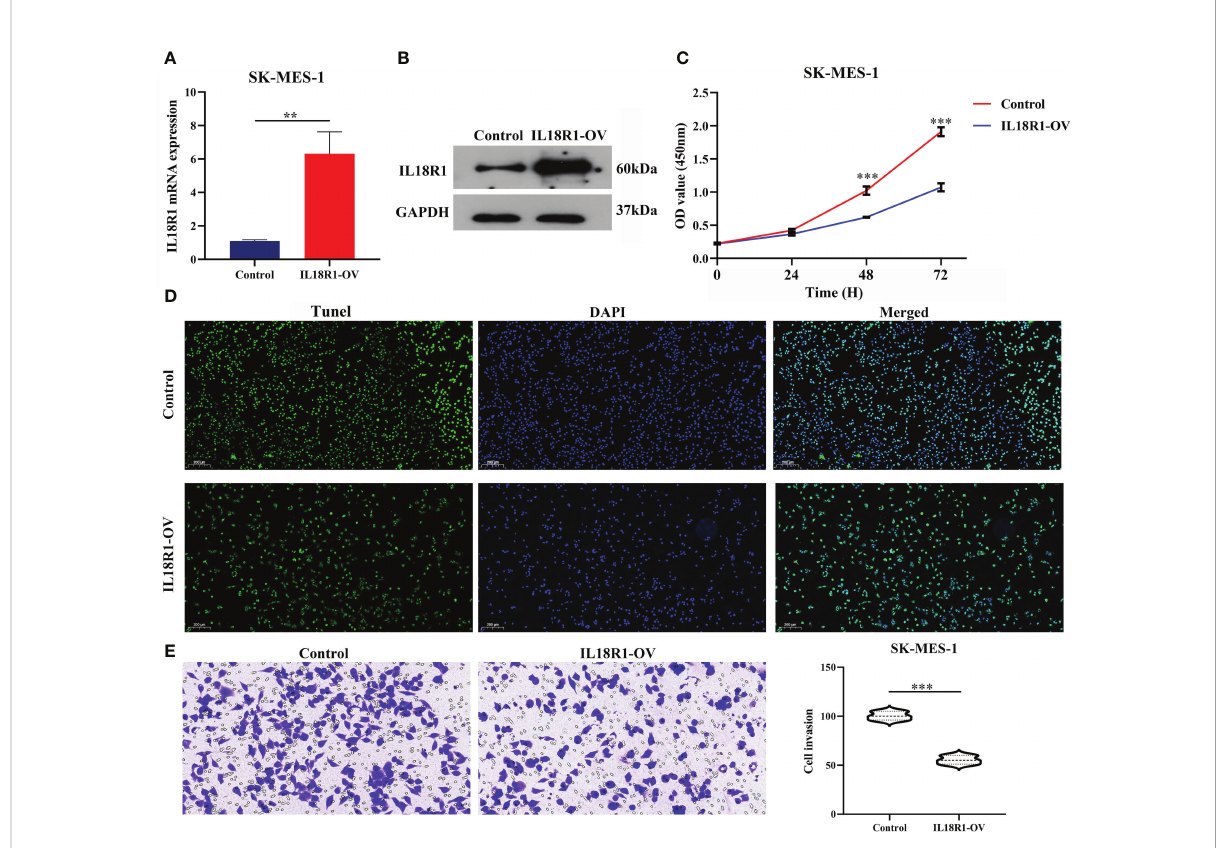
FIGURE 5 IL18R1 over-expression could inhibit the cell growth and invasion in LUSC. (A, B) Validation of cell model using PCR and western blotting; (C, D) Cell growth by CCK-8 and Edu methods; (E) Cell growth by Transwell method. LUSC, lung squamous cell carcinoma; **P < 0.01; ***P < 0.001.